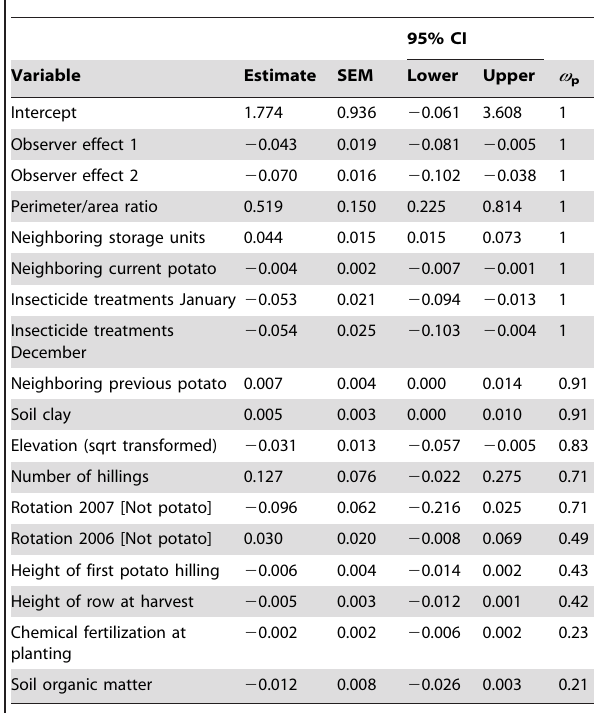
Table 2. Parameter estimates weight-averaged across the 51 ‘‘best’’ models predicting Andean potato weevil infestations (square root of proportion infested